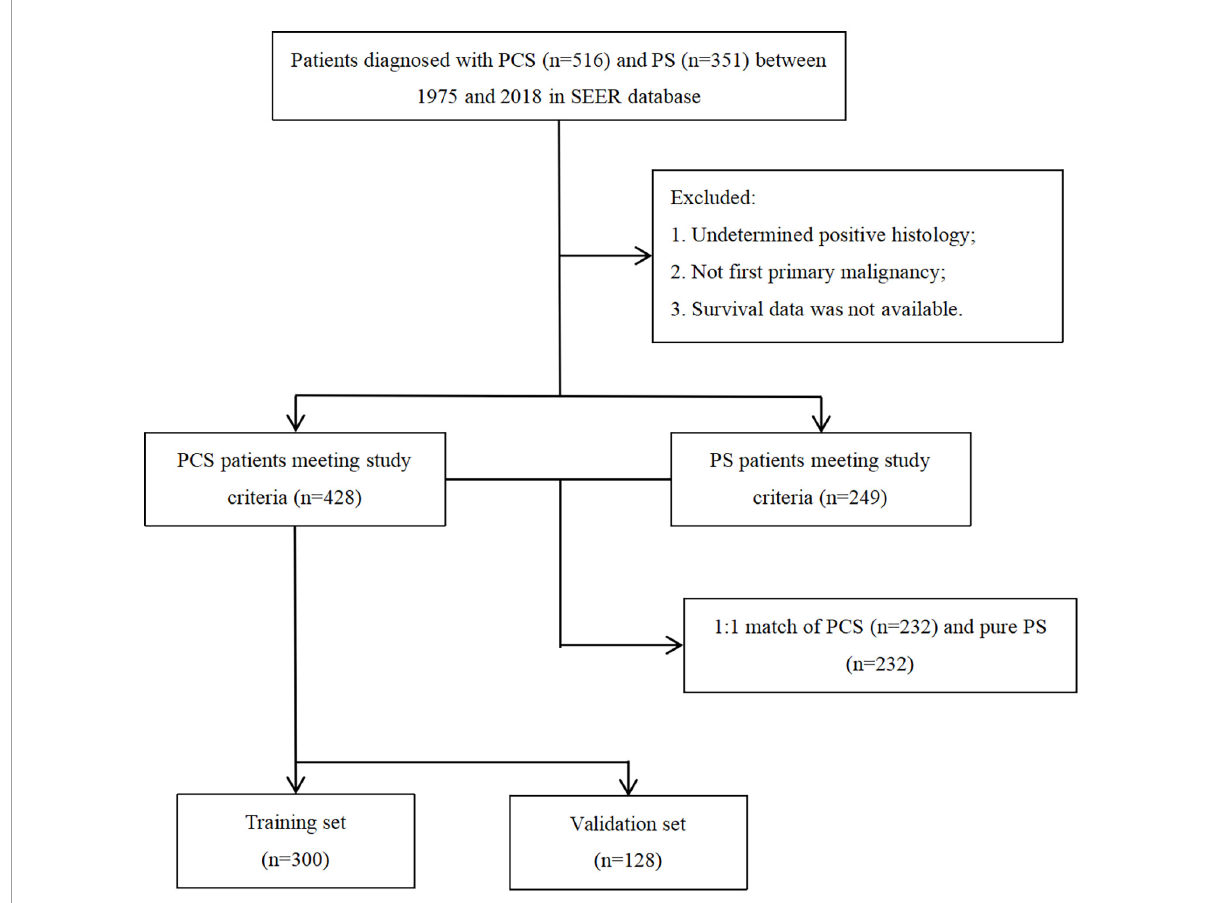
FIGURE1 Patient selection scheme for the